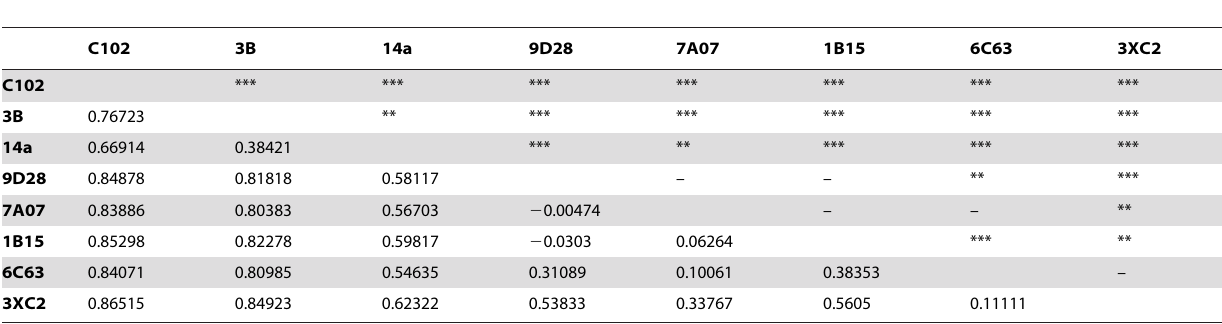
Table 7. Pairiwse Fst values between populations of the quill worm, Hyalinoecia longibranchiata, using a fragment of the COI gene.